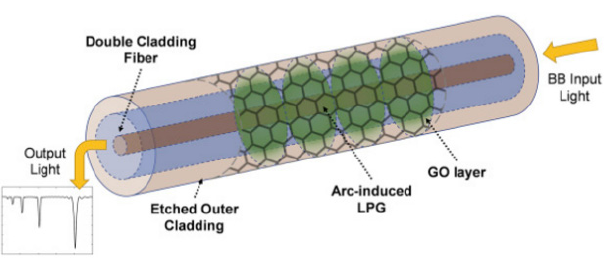
Figure 12. The schematic diagram of a MT-LPG biosensor with W-shaped RI profile. Reprinted with permission from [178].